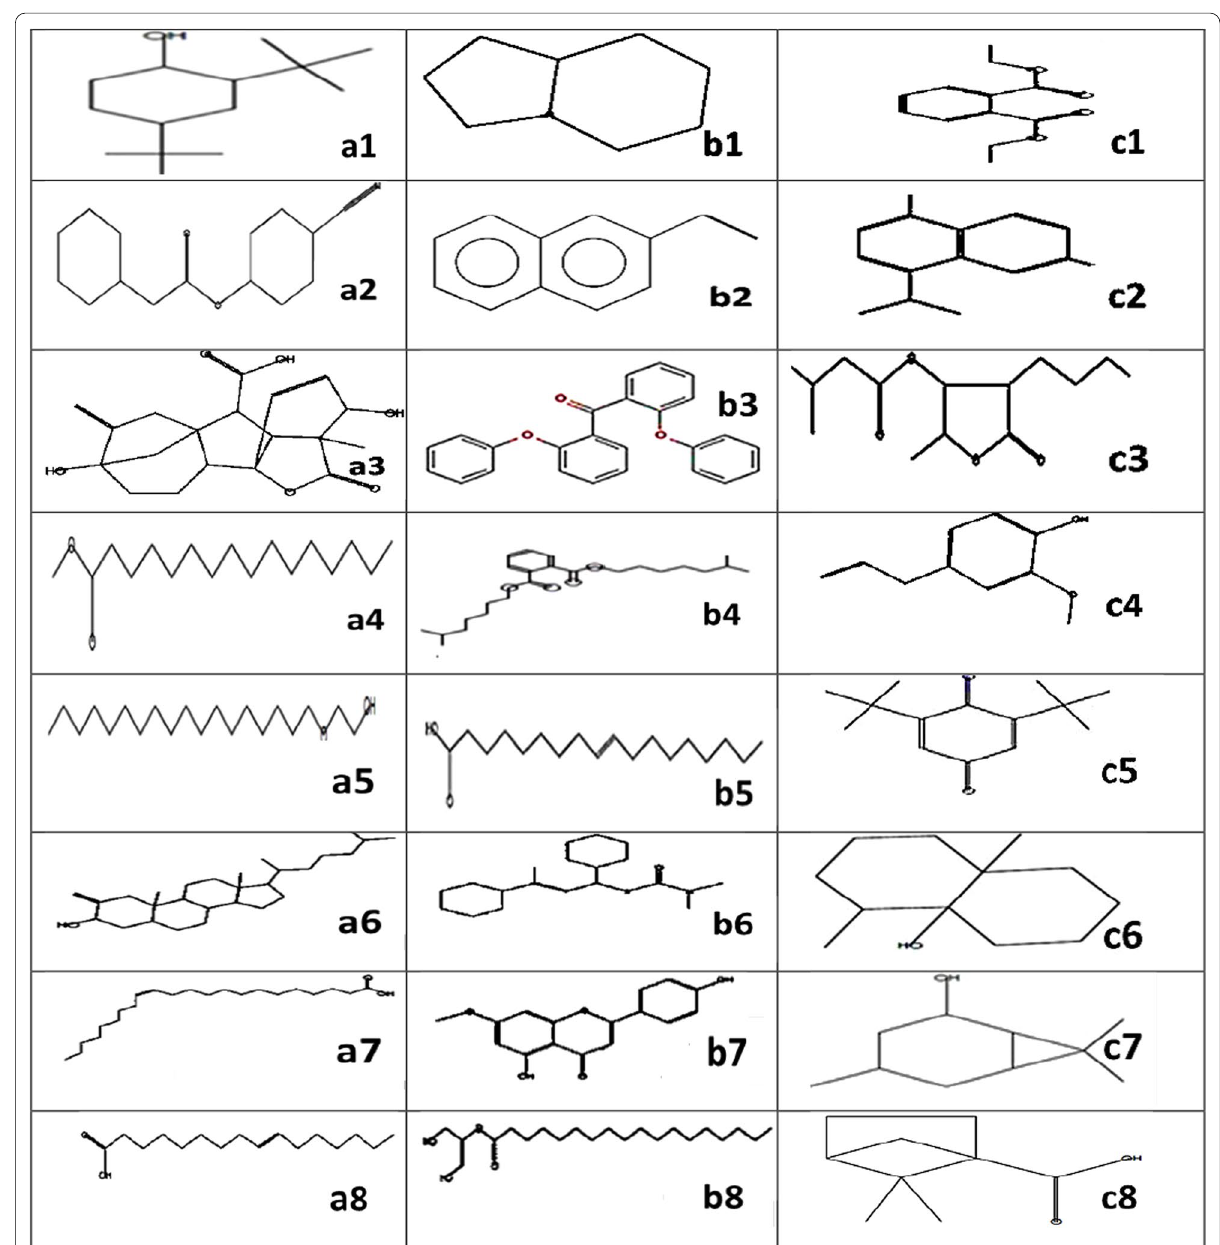
Fig. 3 Molecular structures of the representative compounds. Mass spectrum of the compounds obtained by GC–MS analysis of three Streptomyces spp. were compared with the WILEY 09 and NIST14 mass spectral databases. S. rochei ( a1–8 ): ( a1 ) 2,4‑Di‑Tert‑butylphenol, ( a2 ) Phenyl acetic acid, ( a3 ) Gibberellic acid (GA), ( a4 ) Palmitic acid, ( a5 ) Ethanol, 2‑(Octadecyloxy), ( a6 ) Cholestanol, ( a7 ) 2‑methylene, & ( a8 ) Hexadecenoic acid (Erucic acid). S. griseus ( b1–8 ): ( b1 ) Indole, ( b2 ) Naphthalene, 2‑ethenyl, ( b3 ) Methanone, Bis‑4‑phenoxyphenyl, ( b4 ) 1,2‑benzenedicarboxylic acid (Phthalate), b5 ) Oleic acid, ( b6 ) Thiocarbamic acid, ( b7 ) O‑Methylated Flavone, (Flavonoid or Genkwanin & ( b8 ) 9‑Octadecenoic acid (Oleic Acid). and S. sampsonii ( c1–8 ): ( c1 ) 1,2‑Benzenedicarboxylic acid (Phthalic acid), ( c2 ) Naphthalene, 1,6‑Dimethyl‑4‑(1‑Methylethyl), ( b3 ) 3‑Methyl‑butyric acid ( b4 ) Eugenol phenol,2‑Methoxy‑4‑(2‑Propenyl). ( c5 ) 2,6‑Ditert‑butylbenzo‑1,4‑Quinone, ( c6 ) 2 h‑Naphthol, Octahydro‑dimethyl, ( c7 ) Heptanol and ( c8 ) Hexane‑1‑carboxylic